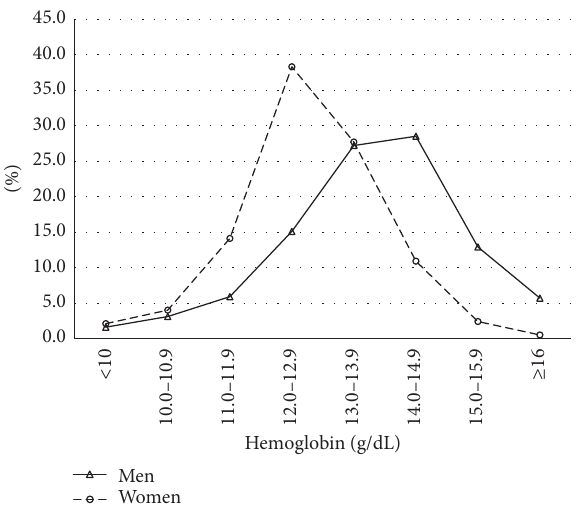
Figure 1: Hemoglobin concentrations among older adults in Ecuador, SABE II survey.